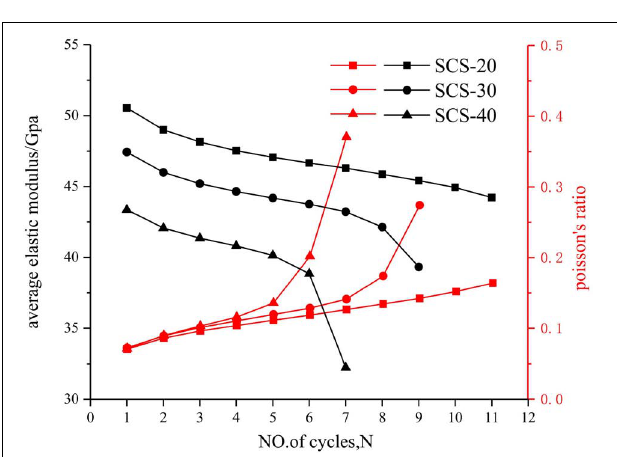
FIGURE 8 | Influence of cycle number on the average elastic modulus (black) and Poisson’s ratio (red) in SCS-20, SCS-30, and SCS-40.